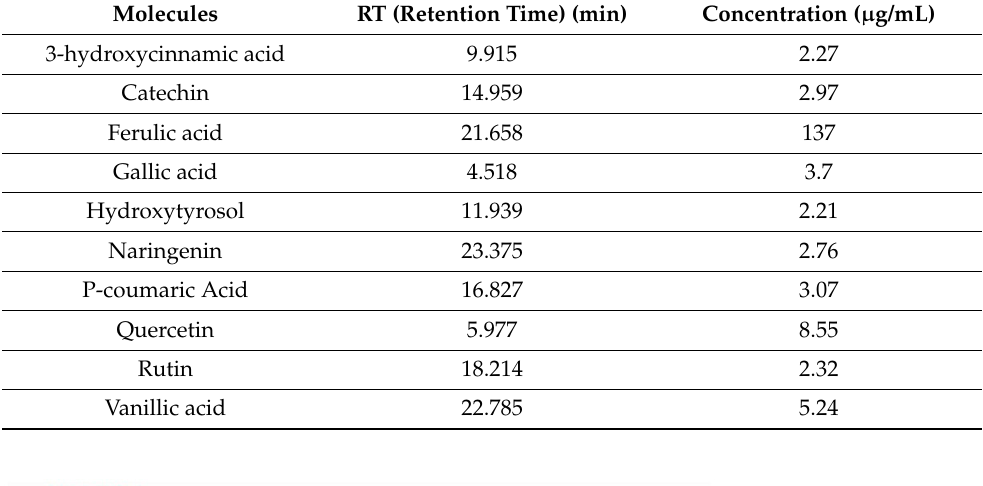
Table 1. HPLC–DAD data of the polyphenolic compounds detected in ZLF aqueous extract.